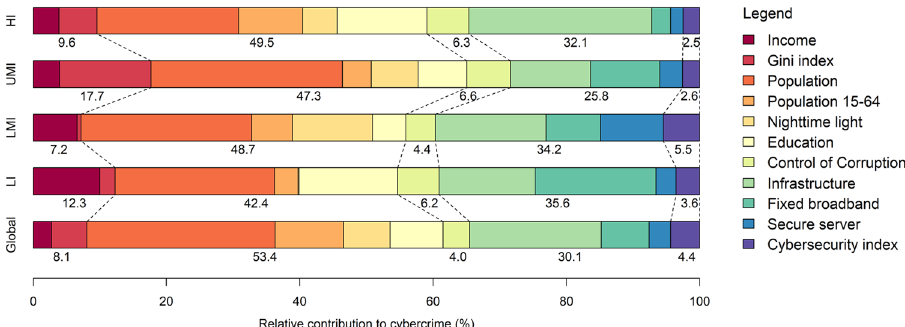
Fig. 3 Relative contribution of predictor variables to